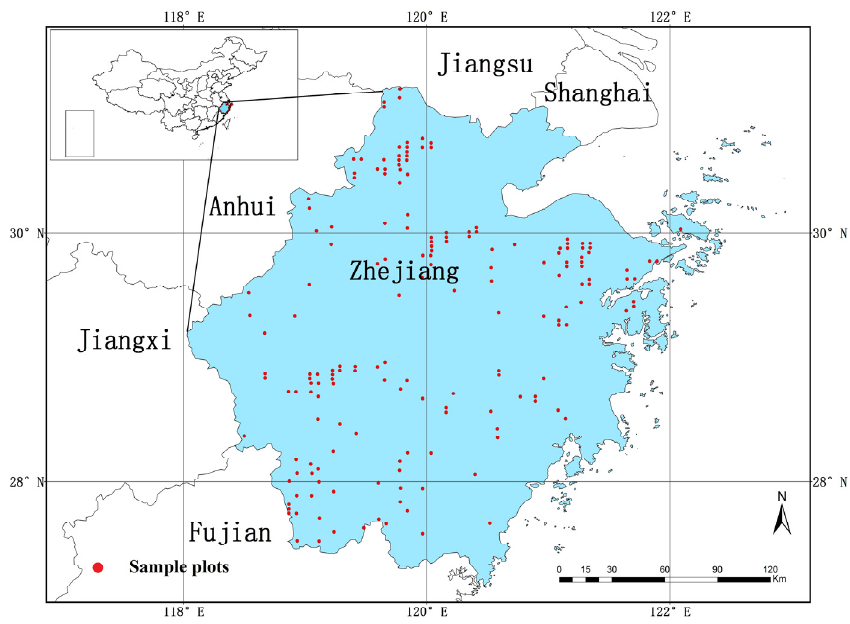
Figure 1. Study area in Zhejiang Province and Moso bamboo forest sample plot locations.